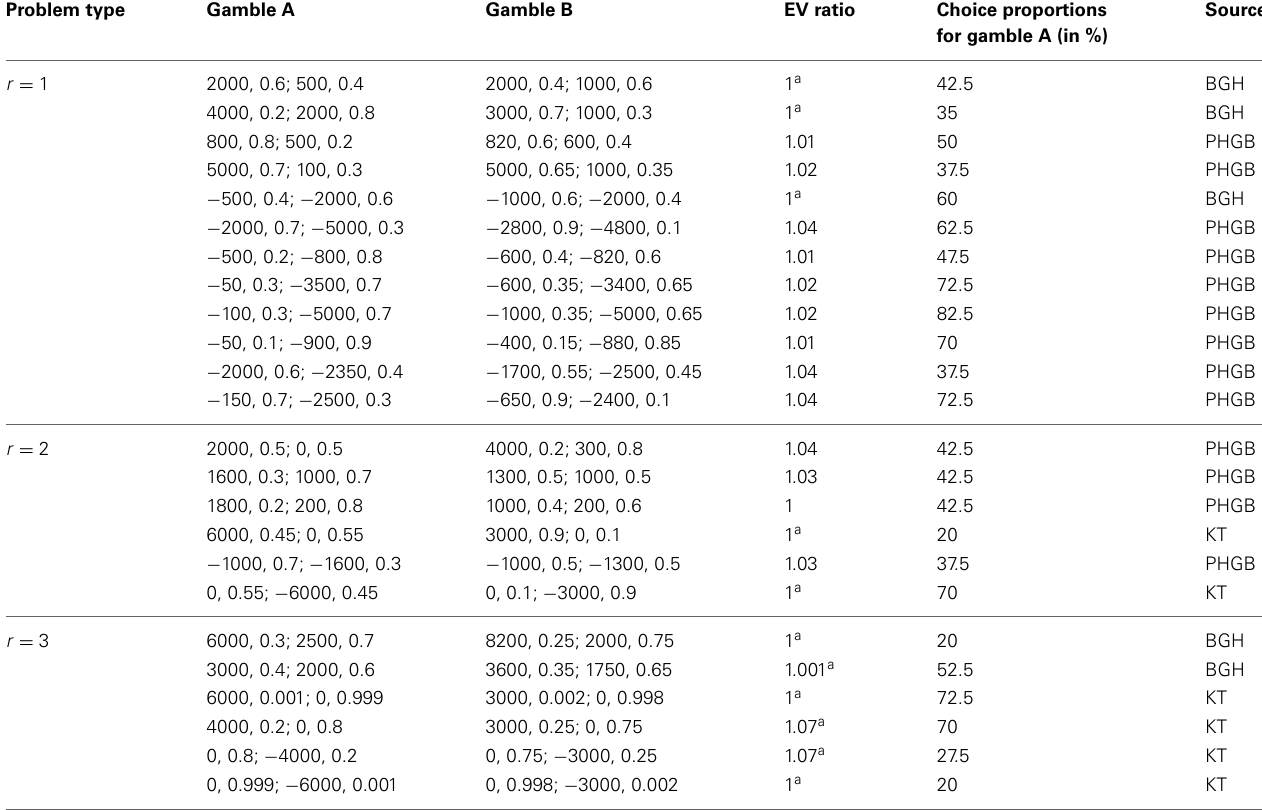
Table D1 | Gamble problems used in Experiment 1 and the obtained choice